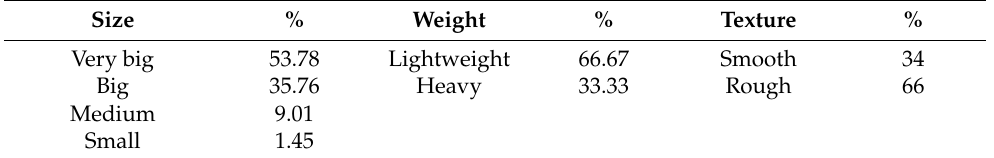
Table 1. Materials preferred by the elderly according to their characteristics (Own production).